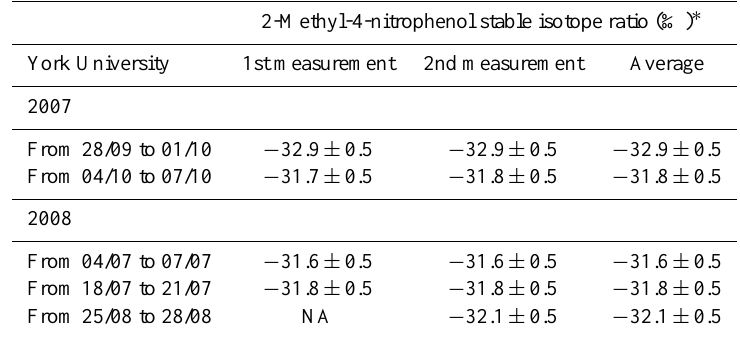
Table 7. Stable isotope ratio (‰) of 2-methyl-4-nitrophenol in ambient particulate matter samples collected at York